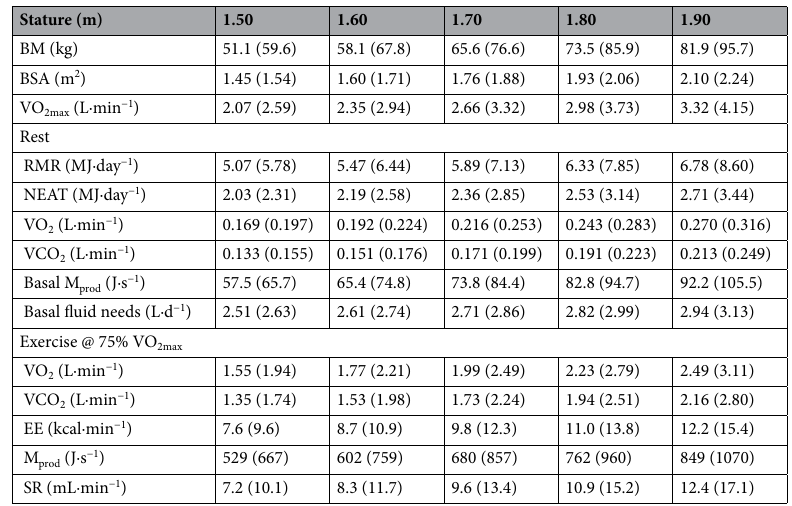
Table 1. Characteristics of the theoretical female and male (in brackets) astronaut populations (see 9 ). BM